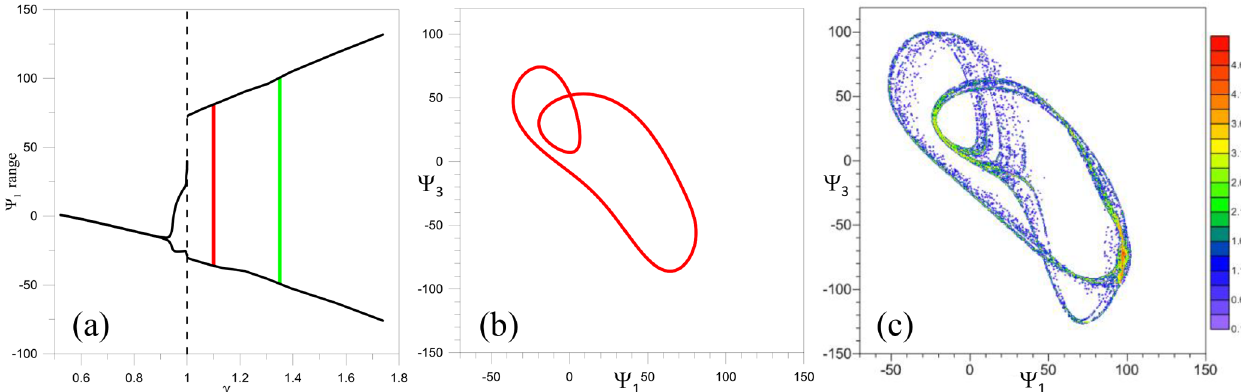
Figure 1. Behavior of the autonomous ocean model, for which ε = 0 in Eq. (3). (a) Bifurcation diagram, in which the range of the variable (cid:57) 1 is plotted vs. the wind stress intensity γ ; the two cases γ = 1 . 1 and 1 . 35 discussed in the text are indicated with a red and a green vertical line, respectively. (b) Limit cycle in the ((cid:57) 1 ,(cid:57) 3 ) plane, plotted after spinup, that arises from (cid:48) for γ = 1 . 1. (c) Map of the suitably scaled PDF of trajectories given by q k ; see text for details.